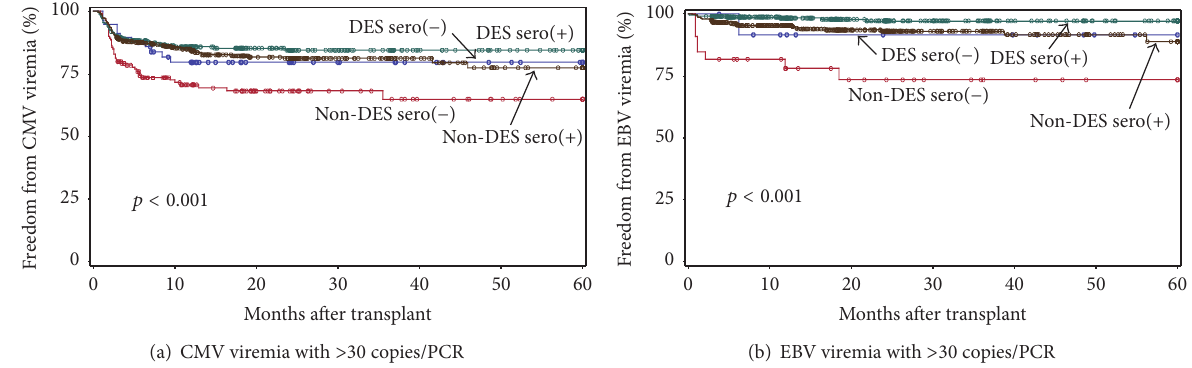
Figure 3: Freedom from CMV (a) or EBV (b) viremia with > 30 copies/PCR in sero(+) (green) or sero( − ) (blue) DES and sero(+) (brown) or sero( − ) (red) non-DES patients during the 1st 5 years after transplant. The group differences were assessed by the log-rank test.